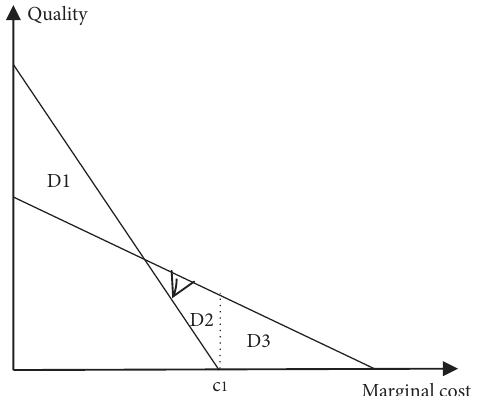
Figure 3: Competitive strategy and degree of competition in the target market (source: